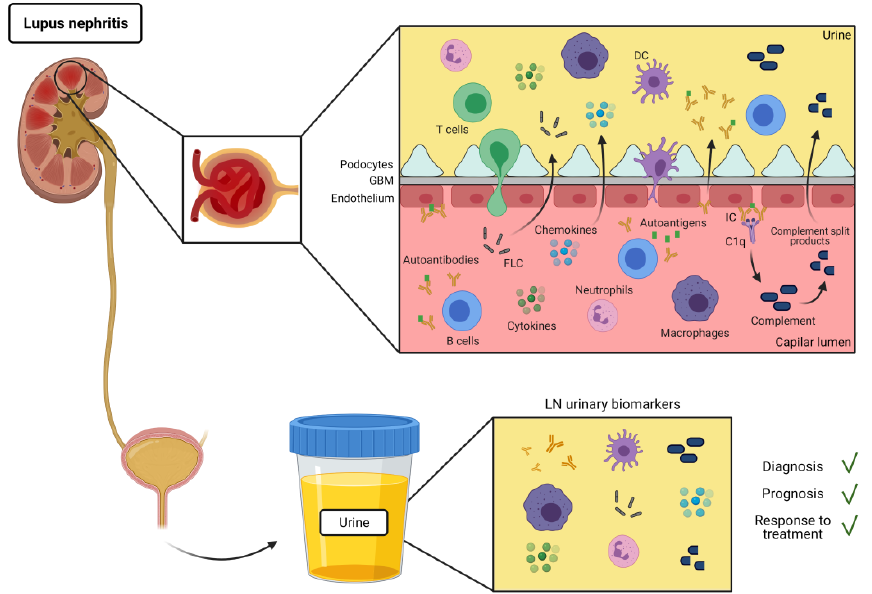
Figure 1. Physiopathology of LN and urine biomarkers. Renal damage in LN is mediated by the infiltration of effector leukocytes, autoantibody binding to nuclear and non-nuclear autoantigens, and generation of IC. These IC are deposed in the glomeruli, affecting the kidney function and leading to an inflammatory cascade. Consequently, filtering of the blood is hindered, and many immune-related cells and molecules involved in the inflammatory response may be excreted into urine. Assessment of these molecules in urine may help to predict the development of LN, renal flares, as well as response to treatment. GBM: Glomerular basement membrane; IC: immune complex; DC: dendritic cell; FLC free light chains.